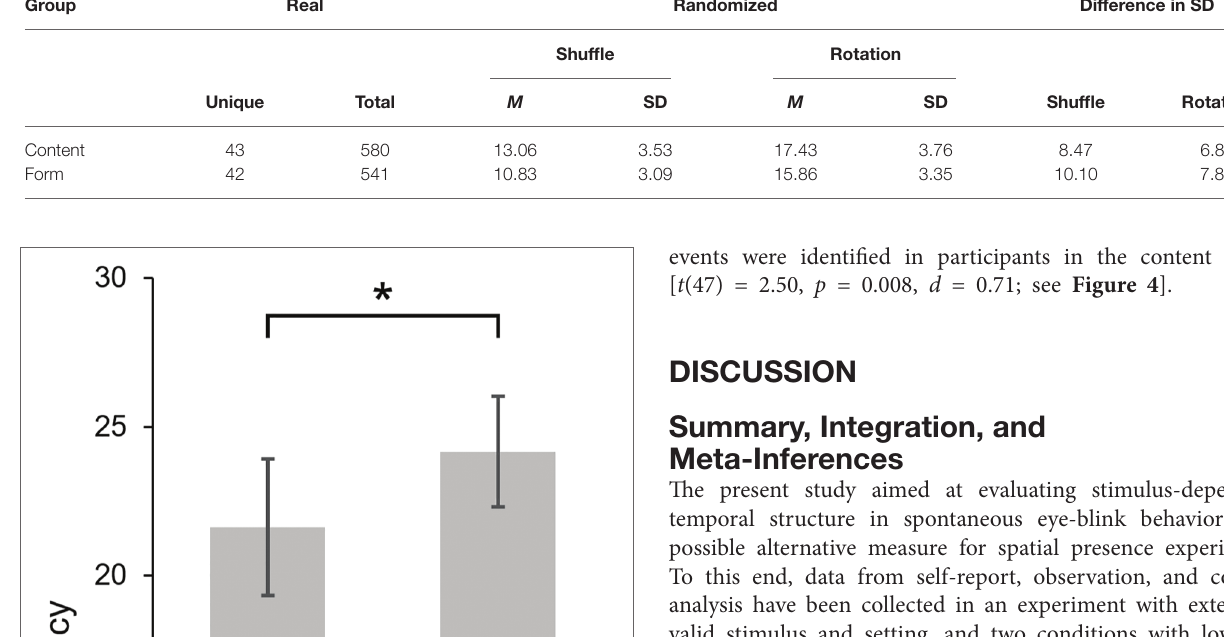
TABLE 1 | T-patterns with blinks as viewer behavior and peaks in optical flow as media events in real data and randomized data. Group